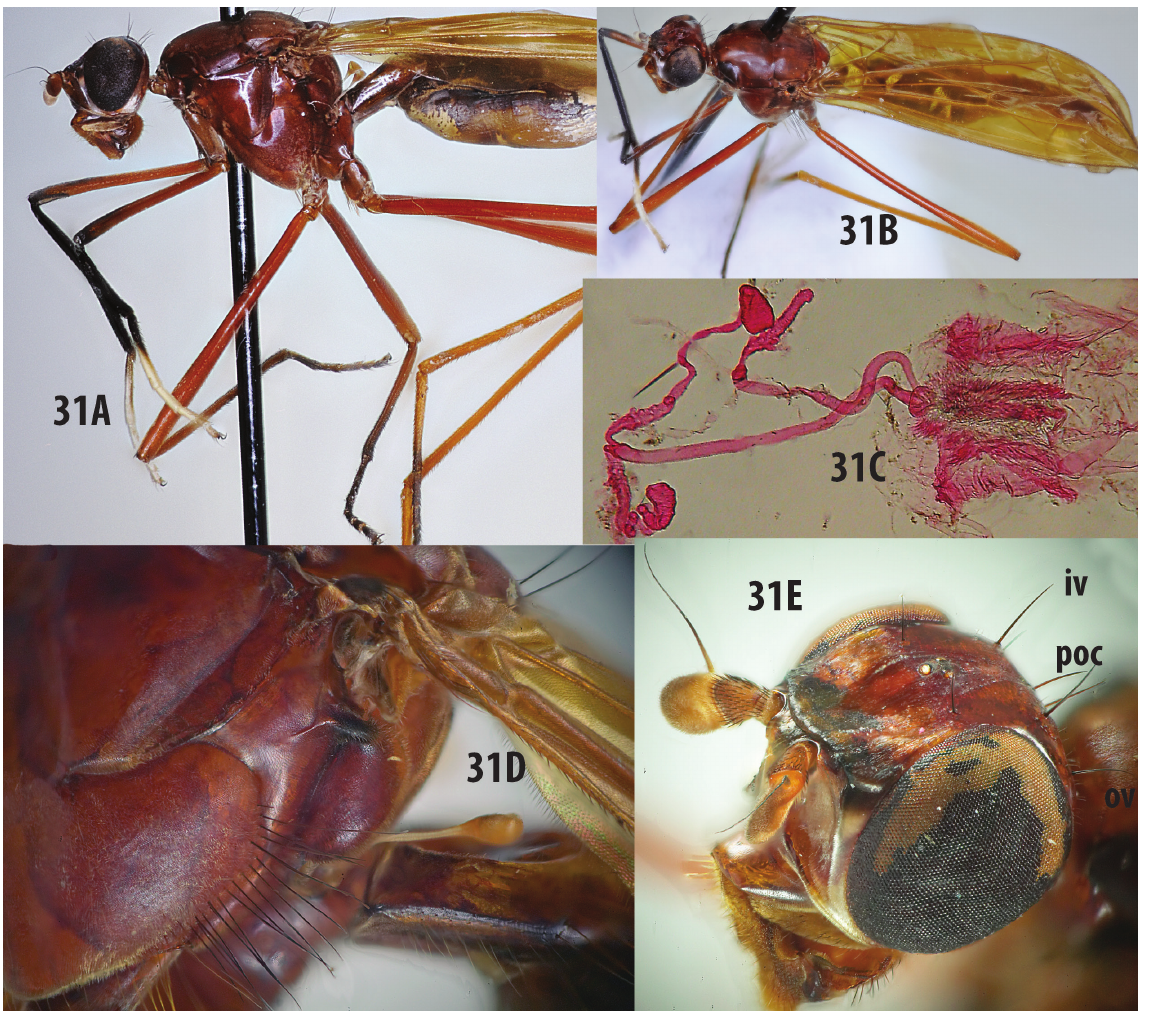
Fig. 31. Mesoconius aurantium sp. nov., holotype, ♀, MUSM. A–B . Habitus. C . Spermathecae and associated structures. D . Pleuron and abdominal base. E . Head. Abbreviations: iv = inner vertical bristle; ov = outer vertical bristle; poc = postocellar